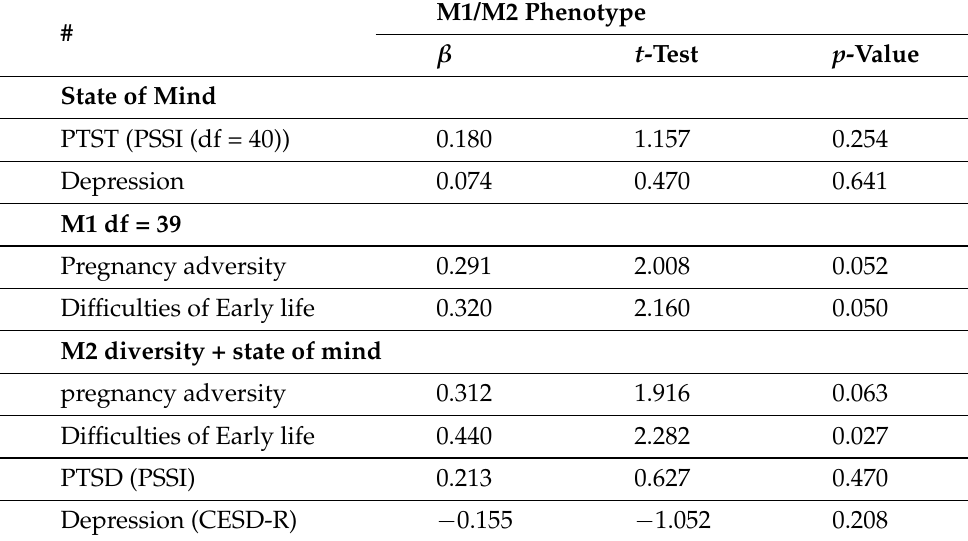
Table 4. Adversity at vulnerable times and mental health symptoms have both single-factor and multiple-factor associations with the M1/M2